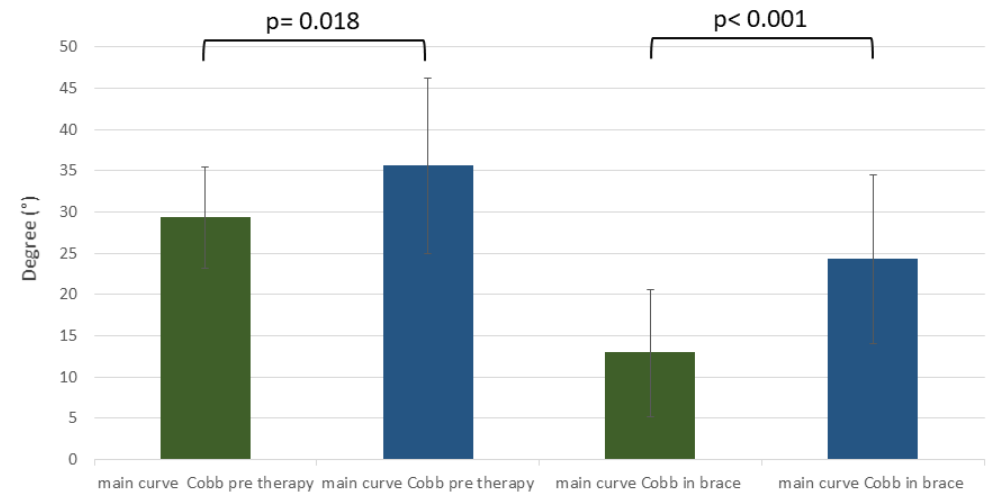
Figure 6. Before brace and in-brace Cobb angle of improvement group (green) and deterioration group (blue).